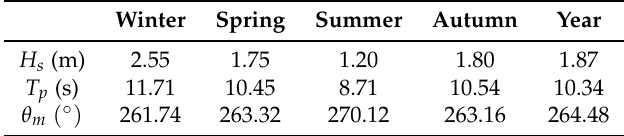
Table 1. Summary statistics of the wave climate at the Belle île measurement buoy located at 47 ◦ 17 (cid:48) N and 3 ◦ 17 (cid:48) W for a 9-year period Oct. 2010–Mar.